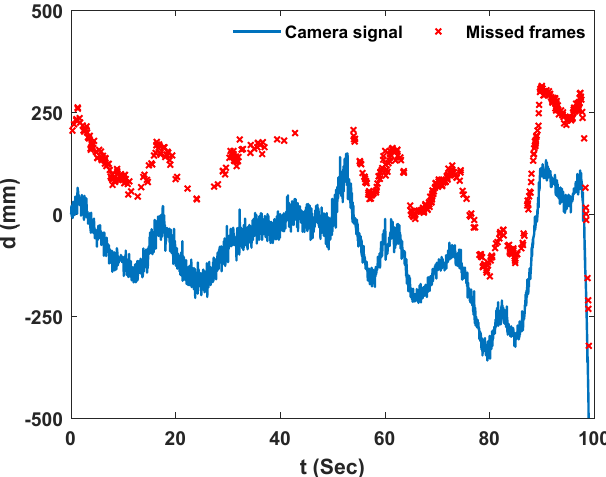
Figure 13. Camera signal in Y direction and the missed experiment frame, experiment 2.